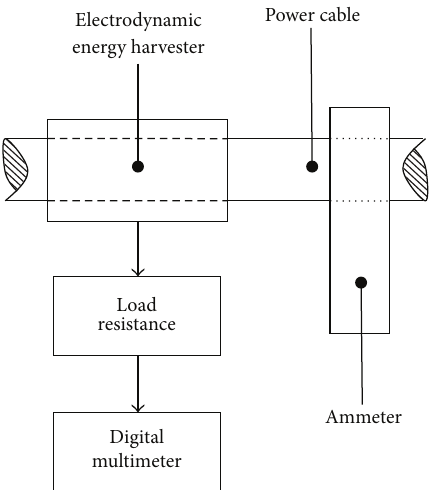
Figure 14: On-spot experimental setup for the characterization of developed energy